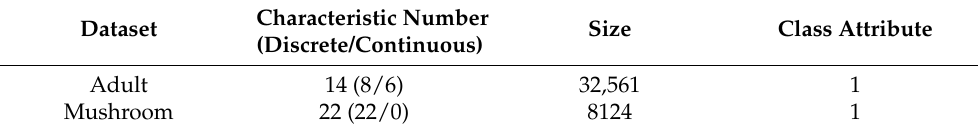
Table 1. Dataset